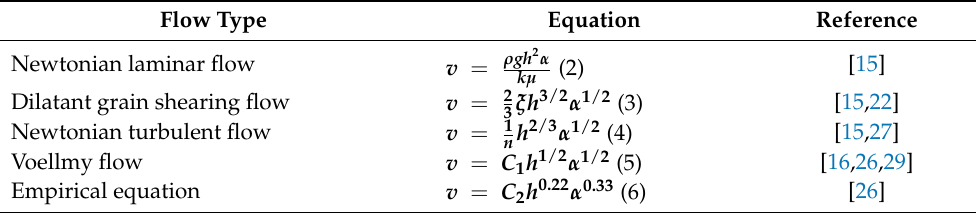
Table 1. Equations used to estimate the mean velocity of debris flow according to flow type. Flow